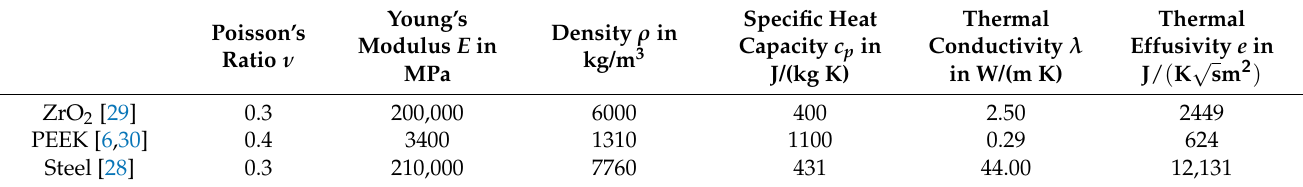
Table 1. Mechanical and thermophysical properties of the considered test and sensor disks at room temperature (20 ◦ C) [6,28–30].